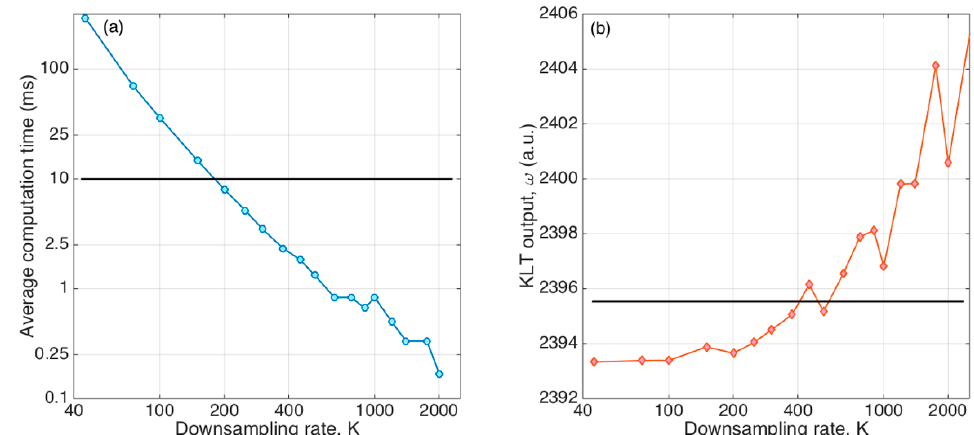
Figure 5. Performance analysis of the KLT as a function of the undersampling rate K . ( a ) Average computation time over 100 KLT calculations as a function of K ; the horizontal line shows the limit of 10 ms computation time for rapid computing. ( b ) KLT output ω as a function of K ; the horizontal line shows the limit of 0.1% variation of ω from the reference value computed with K = 45.